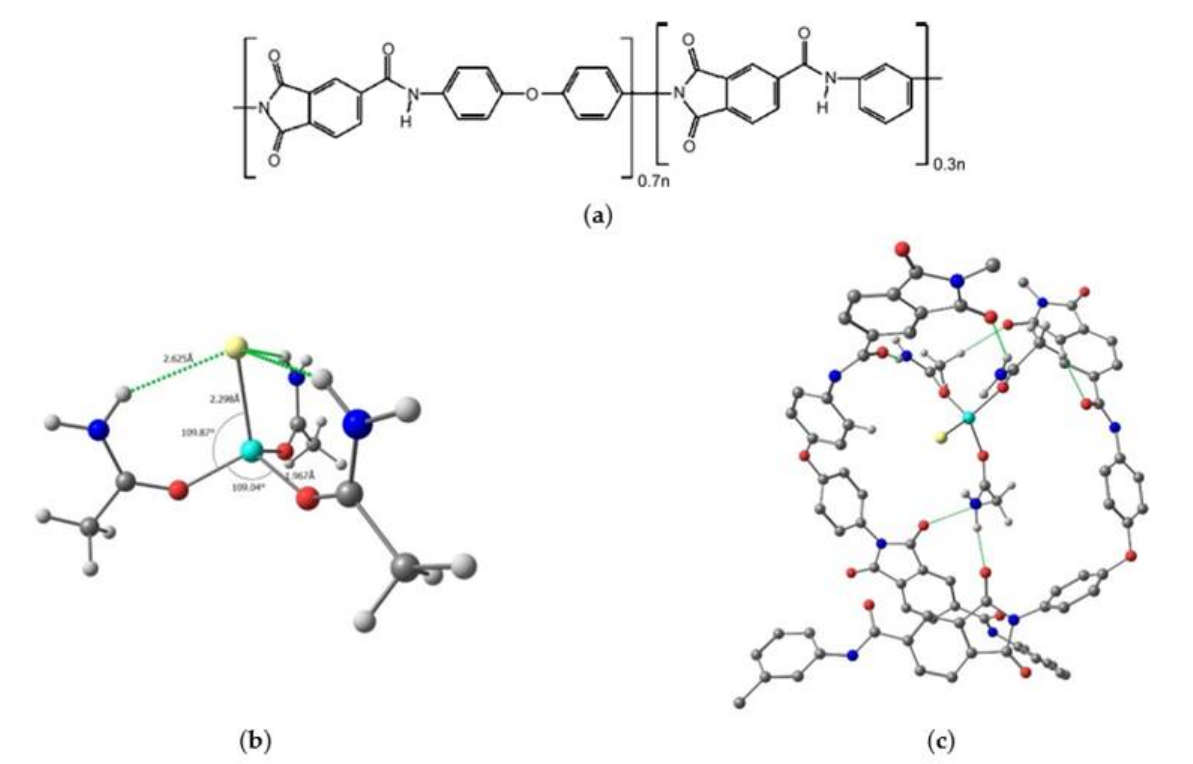
Figure 1. Structural formulas ( a ) PAI Torlon, ( b ) DES composed of ZnCl 2 -acetamide (1:3) and ( c ) Torlon/DES